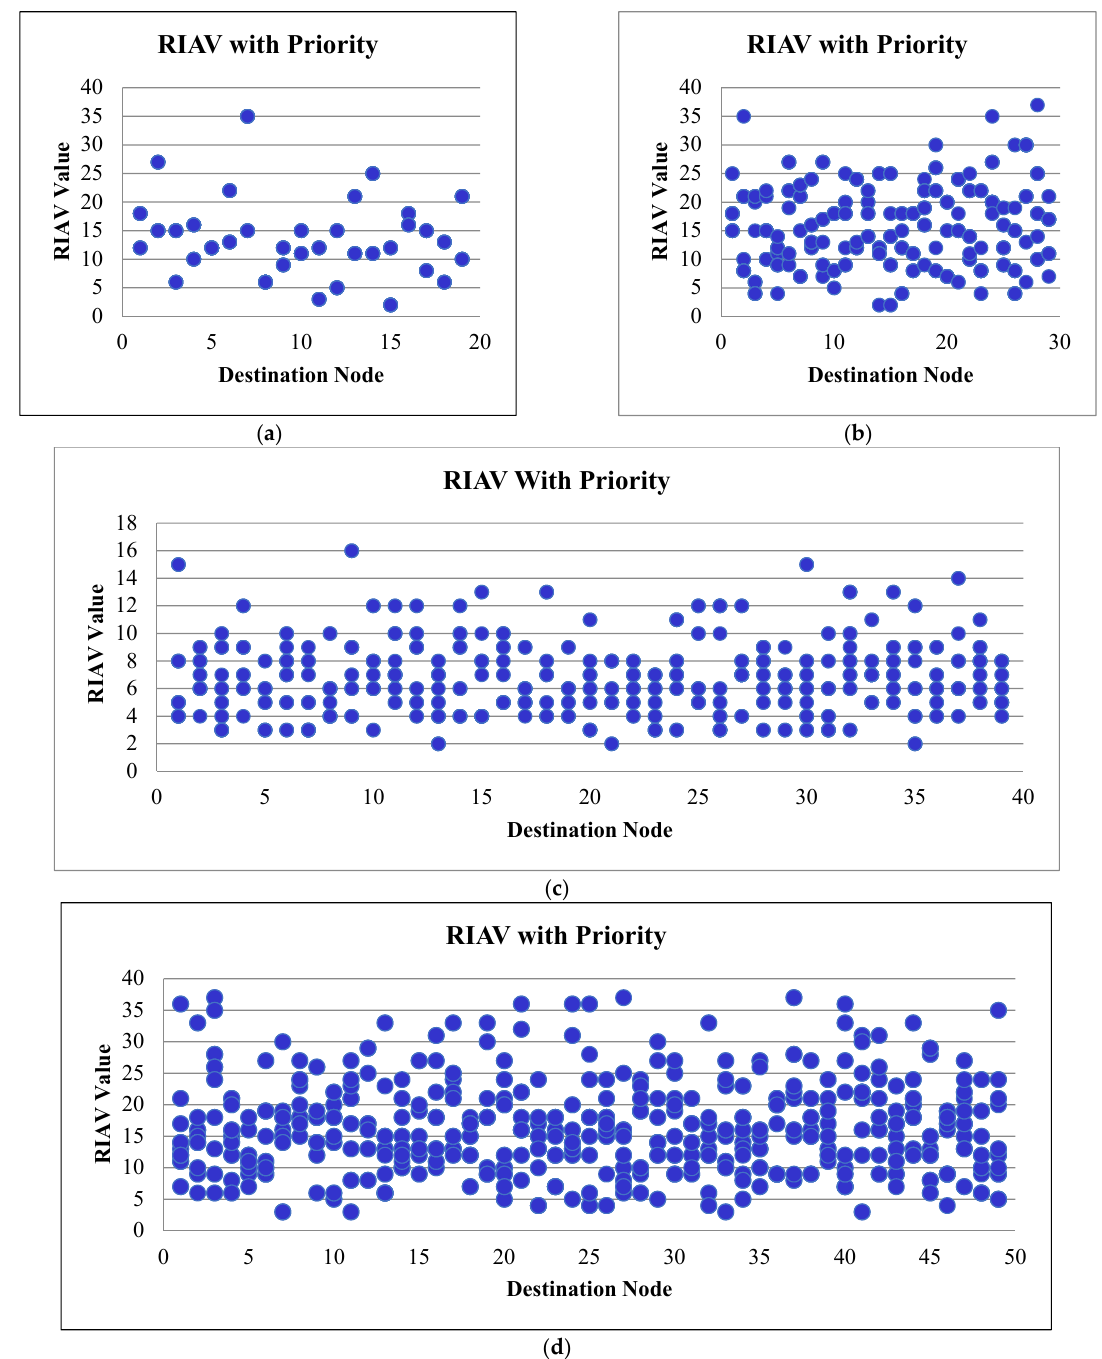
Figure 8. Calculated intersection activation values based on the constraint priority. ( a ) Available paths with 20 nodes; ( b ) available paths with 30 nodes; ( c ) available paths with 40 nodes; ( d ) available paths with 50 nodes.